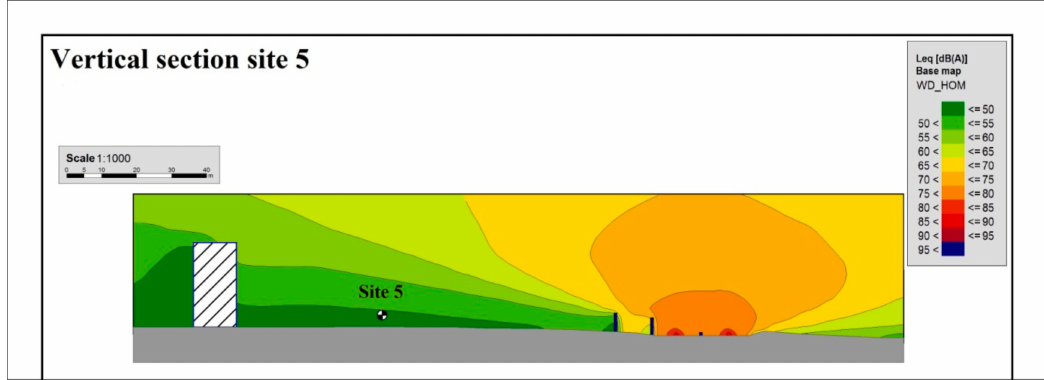
Figure 12. Terrain vertical section corresponding to Site 5. Soil characteristics: playground, vicinity to residential area. Equivalent level intervals are displayed with di ff erent colors. Levels calculated according to the Basic Noise Map